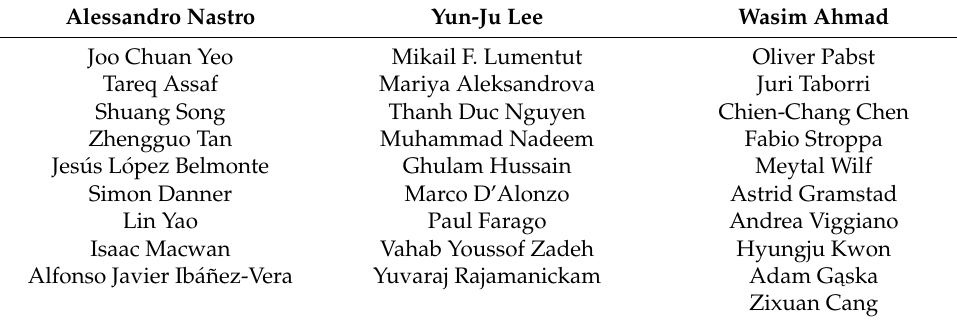
Table A1. Special Issue (SI) reviewer